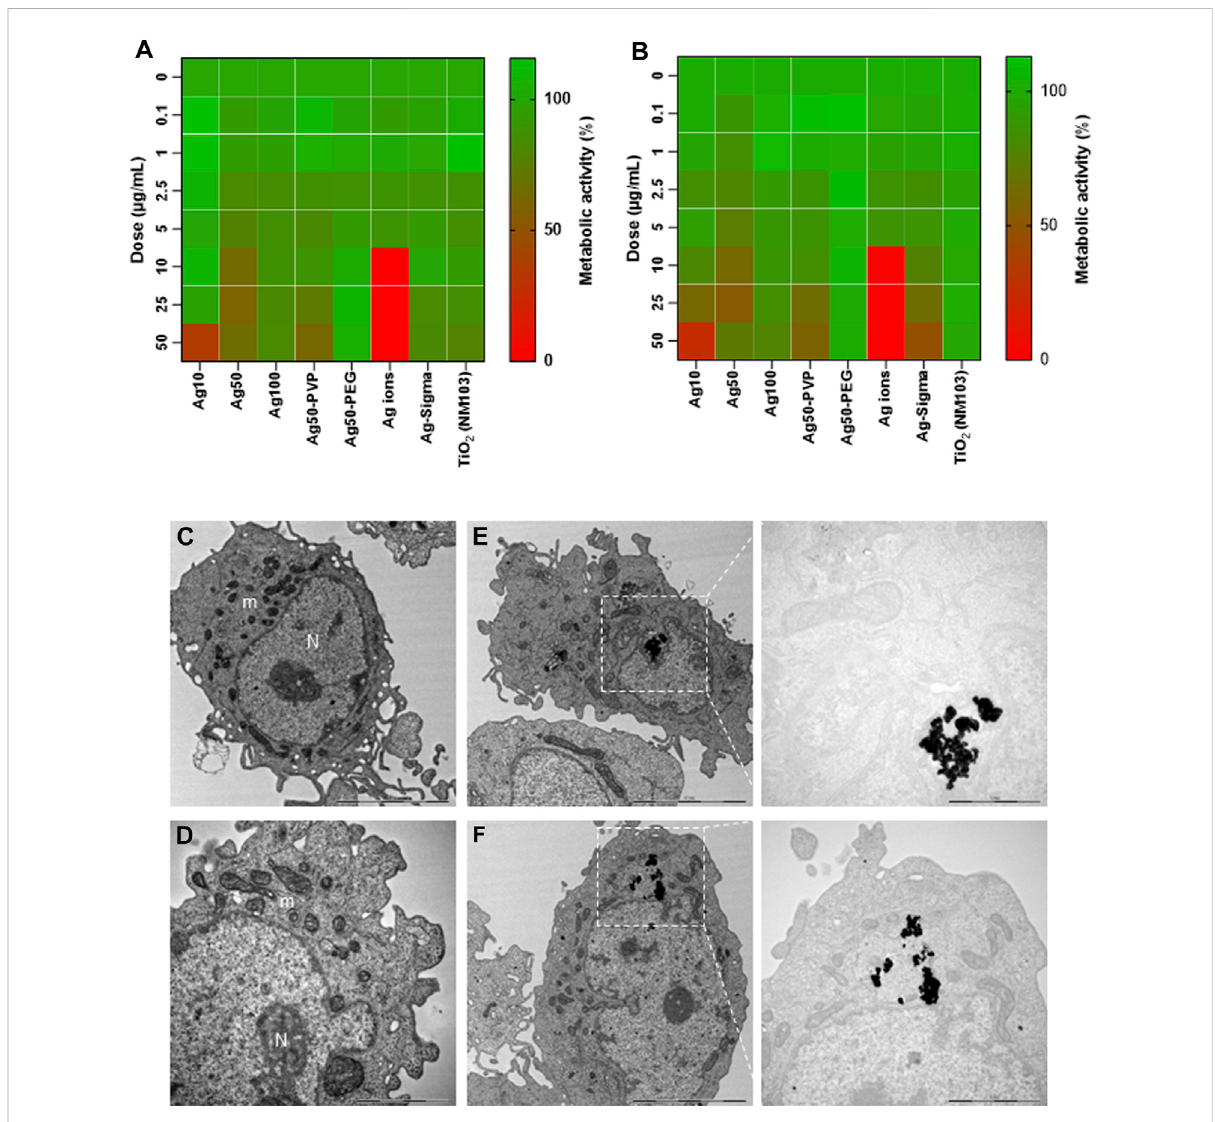
FIGURE 5 Biocompatibility assessment of a panel of NPs. Cytotoxicity of Ag NPs of different sizes and varying surface modi fi cations (as indicated) was evaluated using the human bronchial epithelial cell line BEAS-2B. TiO 2 NPs and AgNO 3 were included as controls. Cytotoxicity (loss of metabolic capacity) was determined by Alamar blue assay after 24 h (A) and 48 h (B) of exposure of the cells. The results shown are mean values of three independent experiments,plottedasheatmaps. (C – F) TEMimaging. BEAS-2Bcellsweremaintainedinmediumalone (C,D)